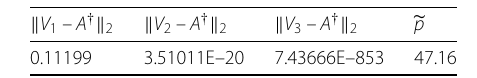
Table 3 Second norm errors and the estimated order of convergence of PCIM for Example